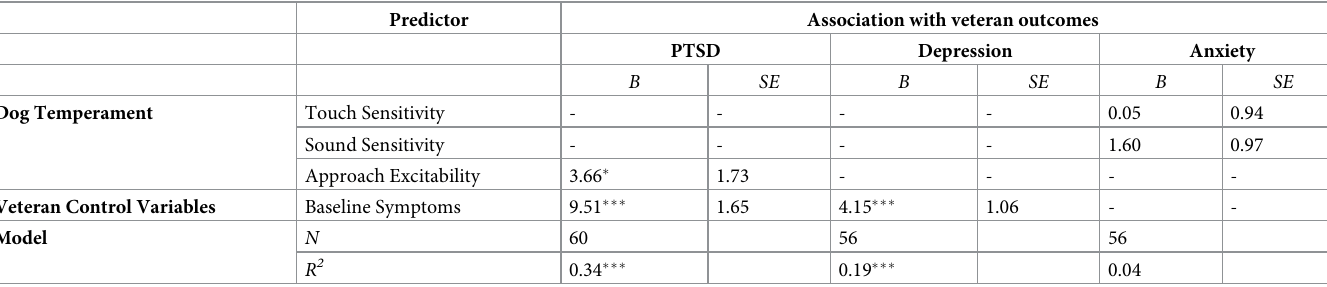
Table 5. Regression outcomes for Aim 1 (predicting veteran outcomes), after variable selection by elastic